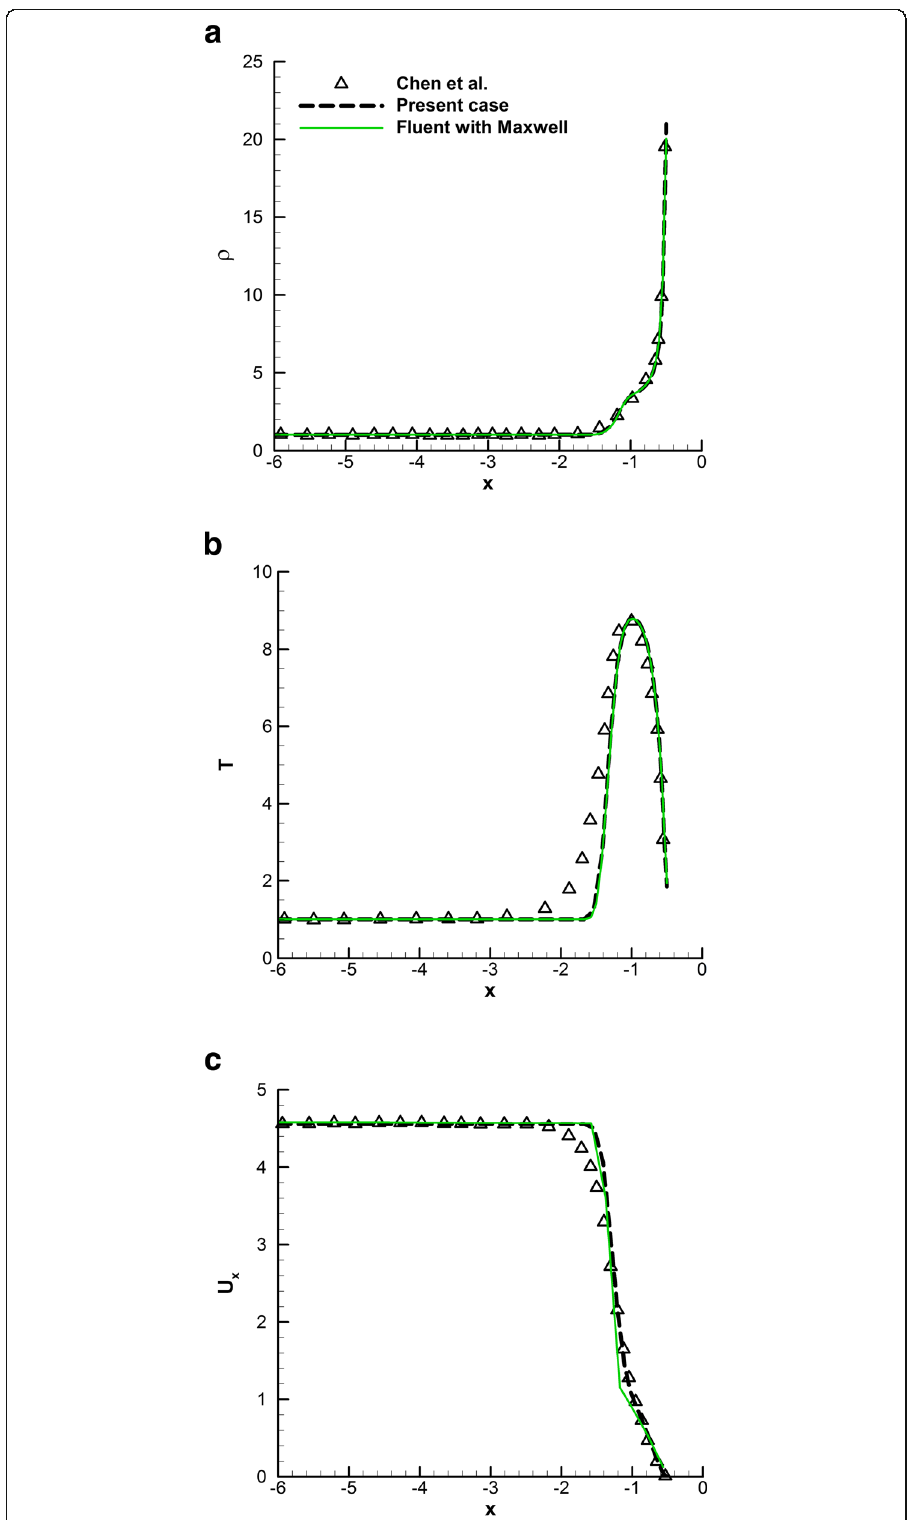
Fig. 4 Comparison of profiles of normalized conserved variables measured along the central line y = 0 at Kn = 0.1 and M = 5.0 with the FLUENT solutions obtained using the Maxwell/Smoluchowski conditions and the Chen et al. [50] results: a density, b temperature, and c U x